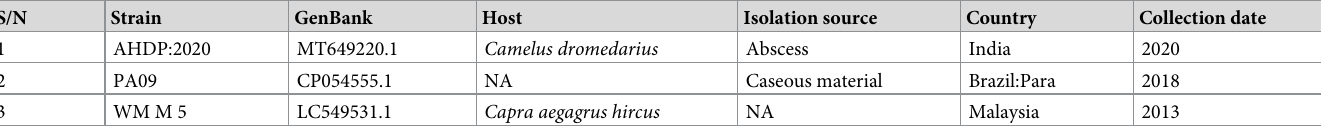
Table 1. The top three close sequences of the Corynebacterium pseudotuberculosis to our isolates, retrieved from BLAST analysis. S/N